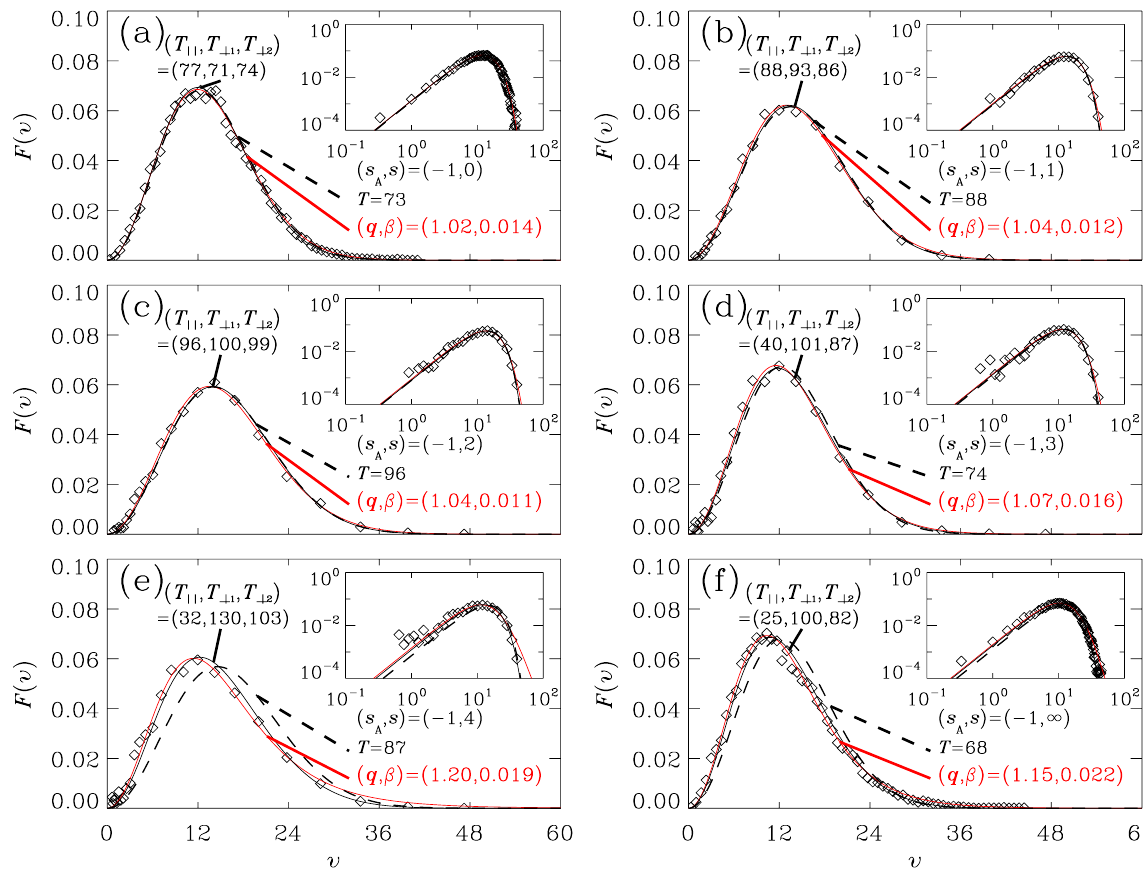
Figure 3. Speed distribution functions P ( v ) as functions of speed v for monomers and their fittings. The ∞ function is computed in such a way that the area ∫ under each curve is unity. Plots (a–f) are, P v dv ( ) 0 correspondingly, for the six systems considered in Fig. 2(a). Simulation data 51, 52 (open circles) are the results averaged over 40 snapshots, collected over a period 0.002 τ (see Methods ). In each plot, the simulation data are compared with the fitted curves of the generalized Maxwell-Boltzmann (GMB) speed distribution P GMB ( v ) defined in Eq. (4) (red solid line), of isotropic Maxwell-Boltzmann (IMB) function Eq. (5), having the same second moment 〈 v 2 〉 as simulation data (dashed line) and of P EMB ( v ), the elliptic Maxwell-Boltzmann (EMB) defined in Eq. (8) (black solid line). While all three fittings provide approximately the same curve as the simulation data for plots (a–c), both the fittings by GMB and by EMB agree with the simulation data better than it is for IMB, for plots (d–f). Note that the values for q shown in the plots are obtained by the fittings over 0.002 τ and fall in the ranges q * ± Δ q (listed in the text below Eq. (7)) obtained by averaging over time periods of 30– 40 τ